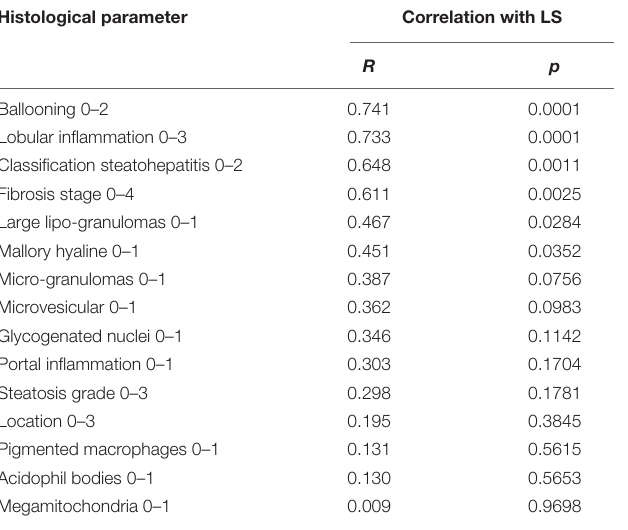
TABLE 2 | Spearman correlations of LS with histological parameters ( n = 23).